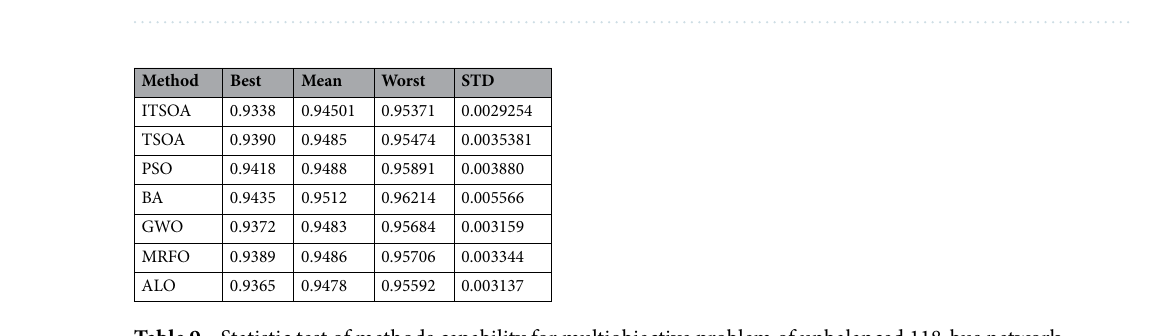
Figure 10. The optimal optimal objective values obtained with different algorithms for the unbalanced 118-bus network.